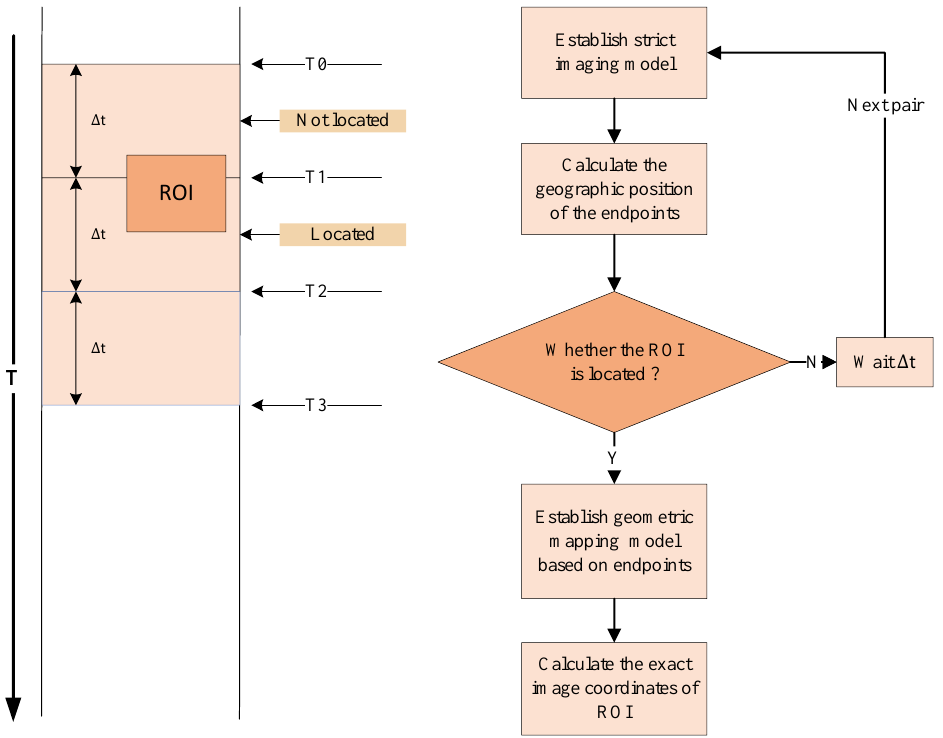
Figure 1. Flowchart of ROI location for linear array sensor data.